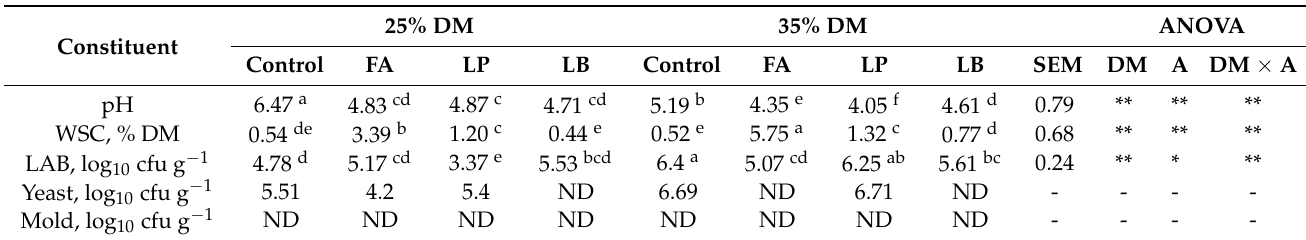
Table 4. Characteristics of pH, WSC and microbial composition of Italian ryegrass silages after 3 days of aerobic exposure.